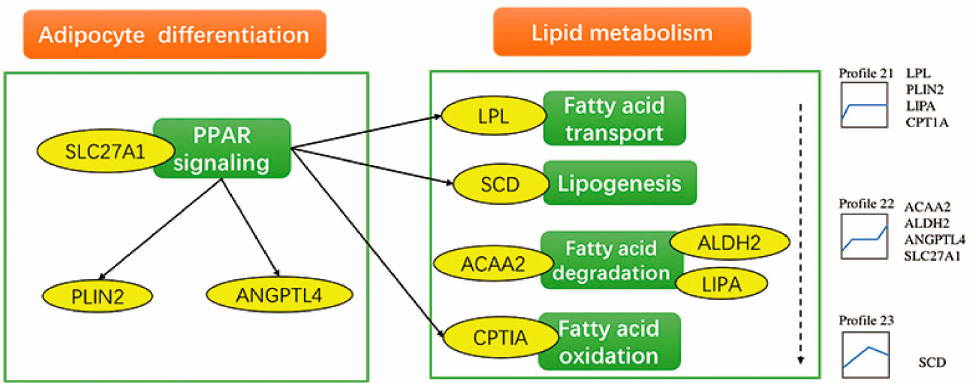
Figure 6. Key DEGs involved in lipid metabolism and adipocyte di ff erentiation. Yellow ovals represent di ff erentially expressed genes identified in this study. Green ovals represent biological processes. Expression patterns of these genes are shown on the